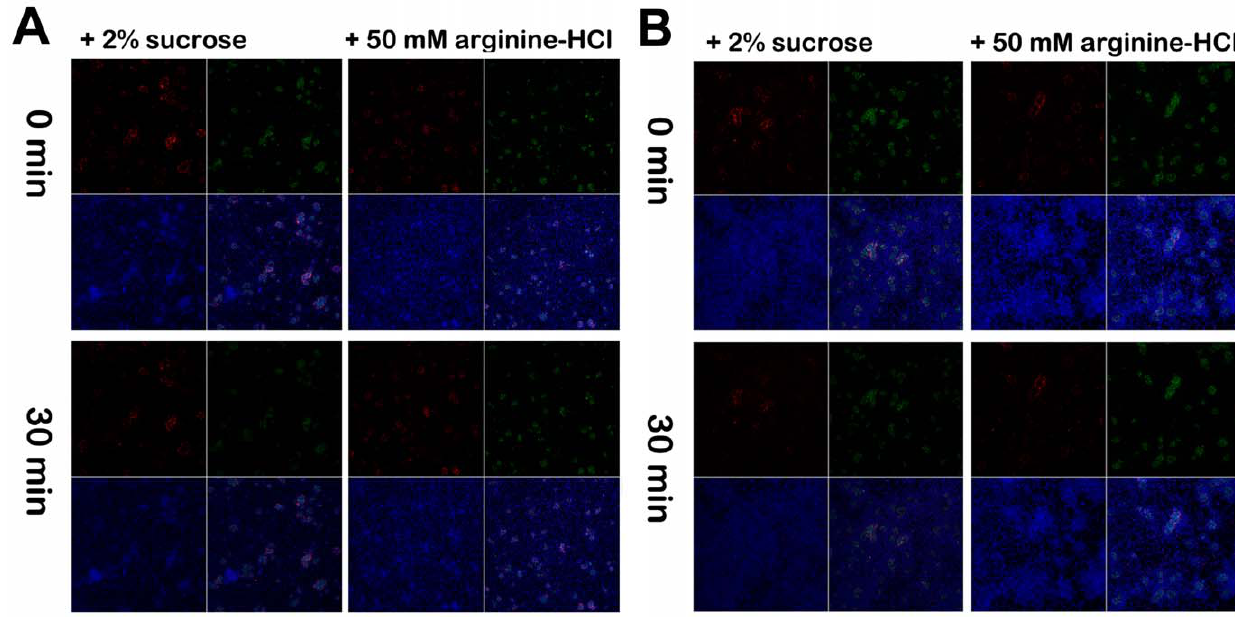
Figure 5. Fluorescence signals of pHluorin-Spap fusion protein in dual- and multispecies oral biofilms. Time-course of surface- expressed pHluorin fluorescence signal in 16 h S. mutans O87 and S. sanguinis dual-species biofilm (A) and saliva-derived biofilms (B) after challenged with 2% sucrose or 50 mM arginine-HCl (pH 7.6). At different time points (0 and 30 min), biofilms were stained with the anti- S. mutans monoclonal Ab SWLA1, the secondary Ab Alexo 633 conjugated goat anti-mouse IgG and CellTracker Orange. SWLA1 (red), CellTracker Orange (blue), GFP (green) and the corresponding overlay images are shown in the four small panels.